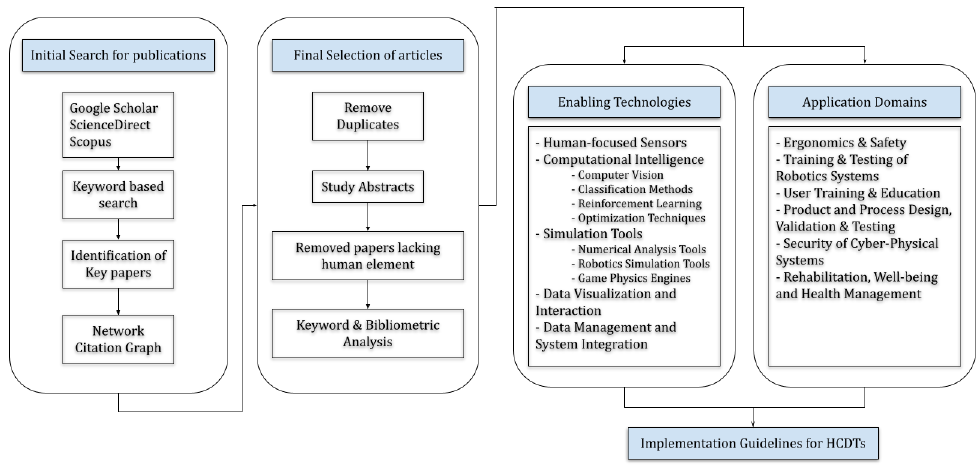
Figure 2. Methodology &